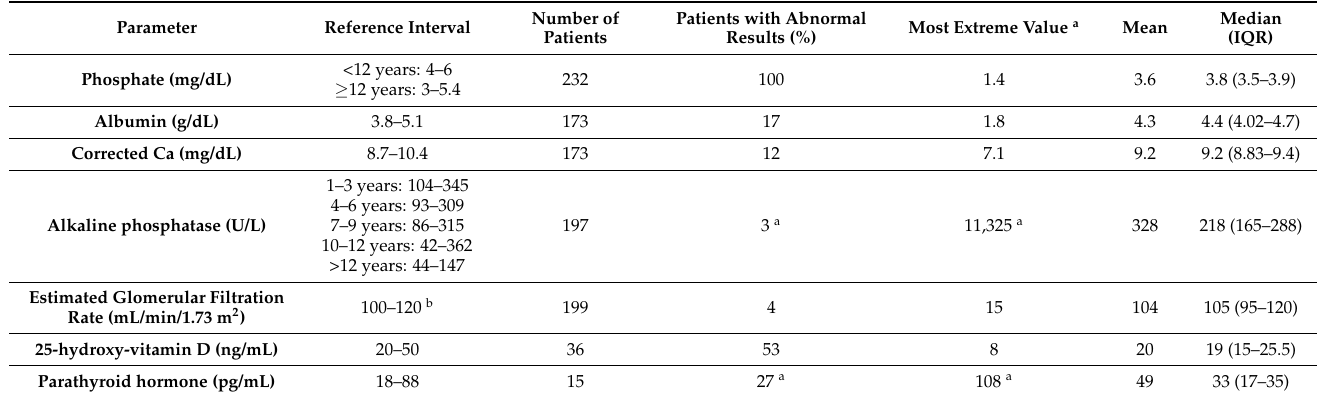
Table 1. Biochemical variables in patients with hypophosphatemia.